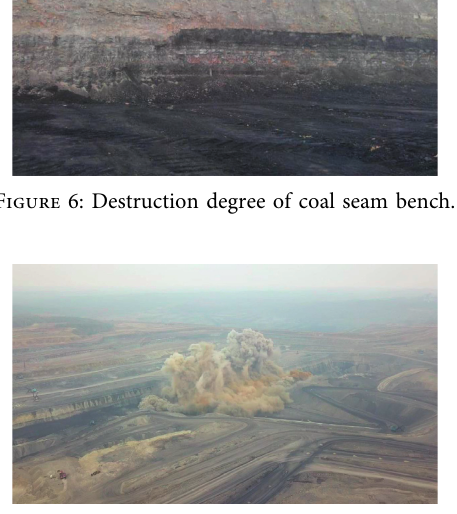
Figure 7: Dust pollution.